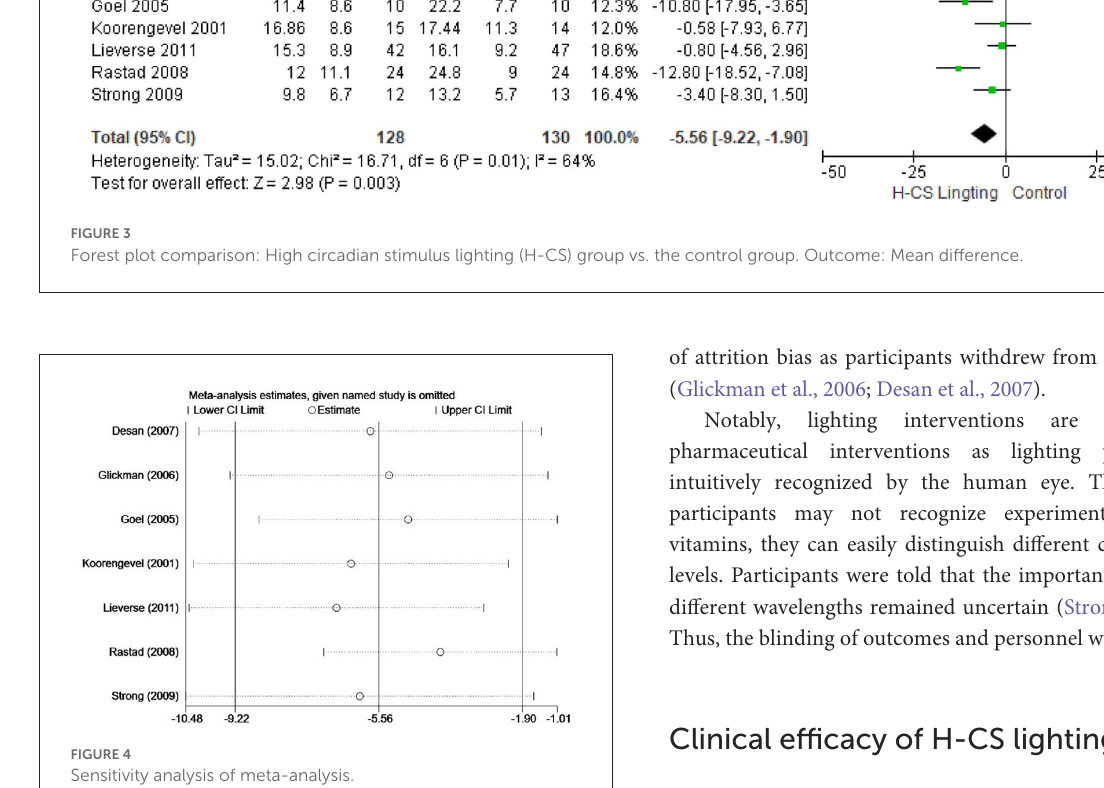
FIGURE4 Sensitivity analysis of